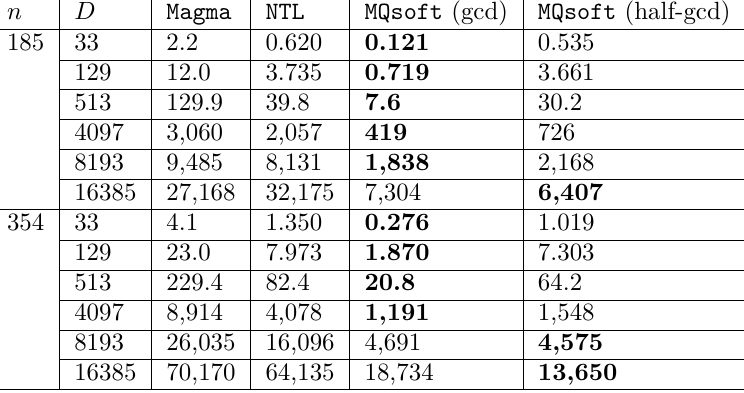
Table 13: Number of mega cycles to compute the GCD in F 2 n [ X ] of a D degree polynomial by a D − 1 degree polynomial. We use a Skylake processor (LaptopS).